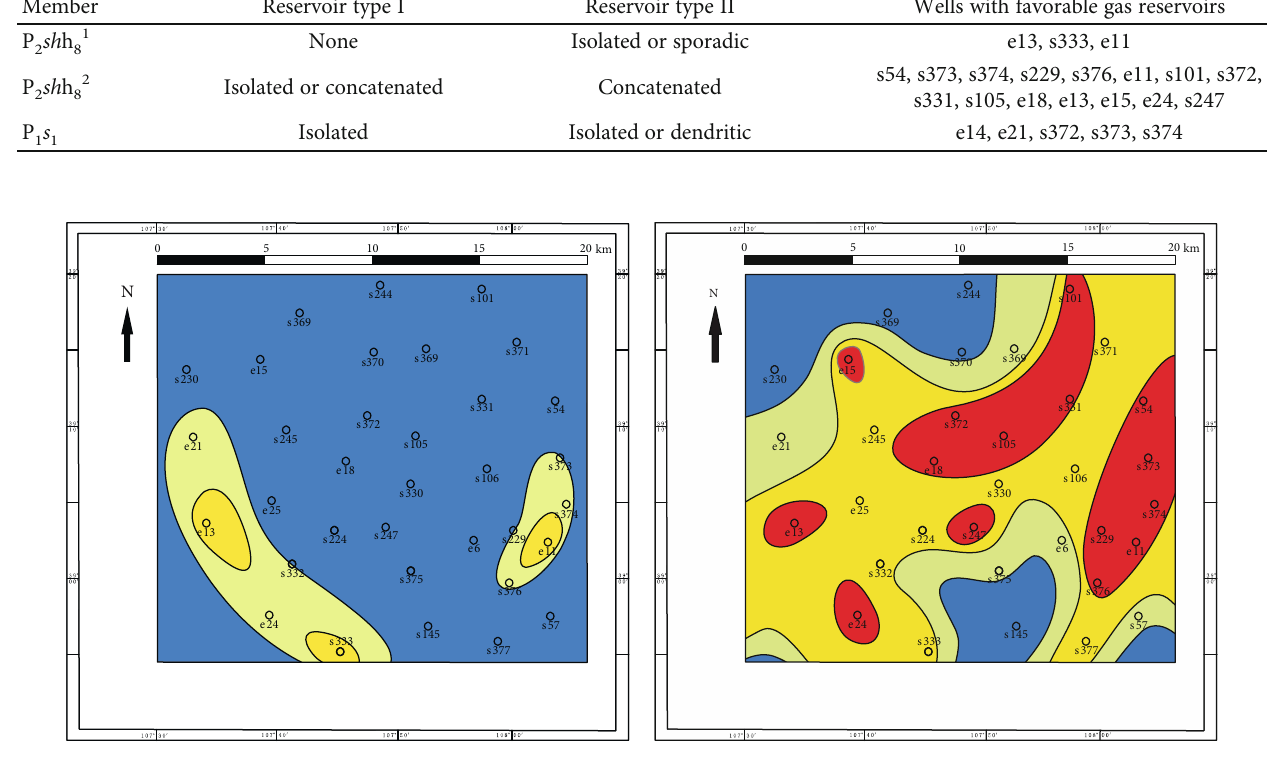
Figure 5: Prediction of favorable gas zones for (a) P Sulige gas fi